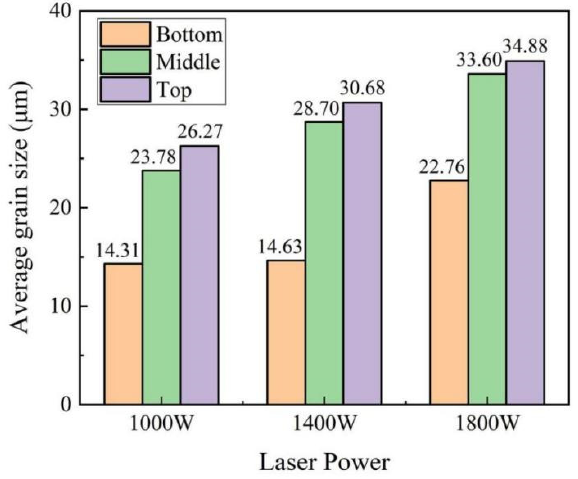
Figure 7. Average grain size of the Al 0.5 FeCoCrNi HEA manufactured by